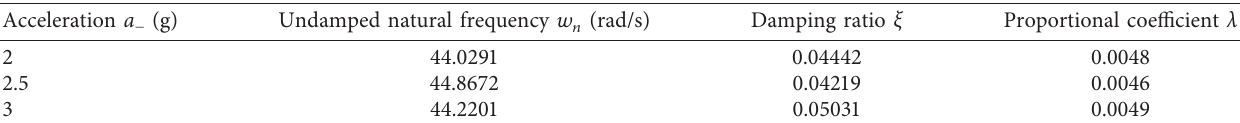
Table 3: ARMA recognition results of trapezoidal move profile